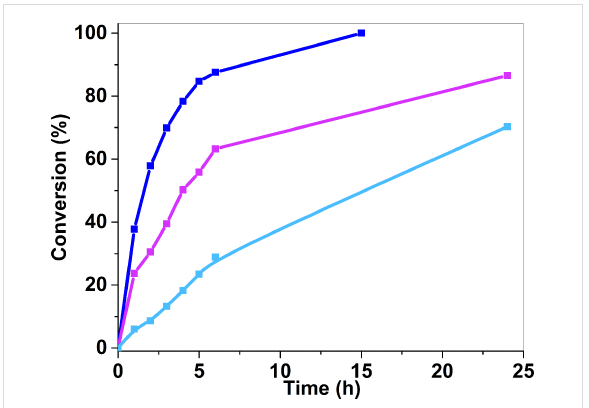
Figure 7: Monitoring over time of benzyl alcohol oxidative dehydroge- nation conversion for successive additions of 1 mmol BnOH in the reaction medium (each reaction was carried out during 24 h) using (A 300 ) as a catalyst. (A 300 ) 1 represents the conversion (%) while using the catalyst for the first cycle (blue), (A 300 ) 2 for the second cycle (pink) and (A 300 ) 3 for the third cycle